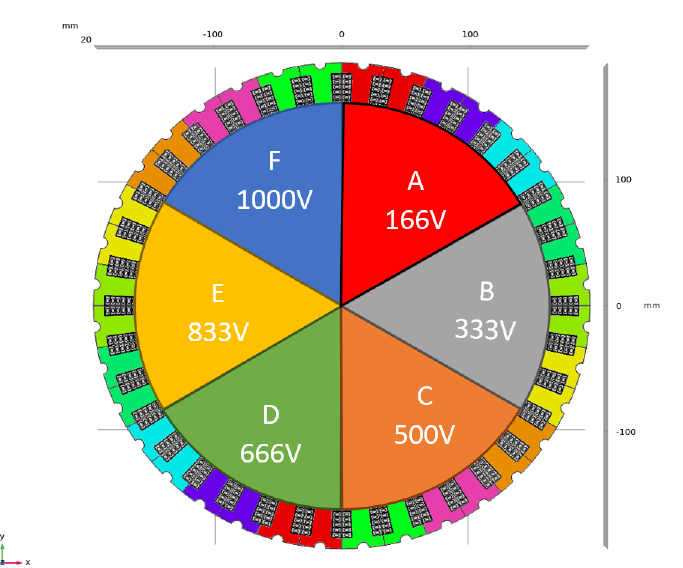
Figure 1. Scheme of the motor with its sections, each fed by a PWM supply, and the relevant nominal (maximum) voltage levels.